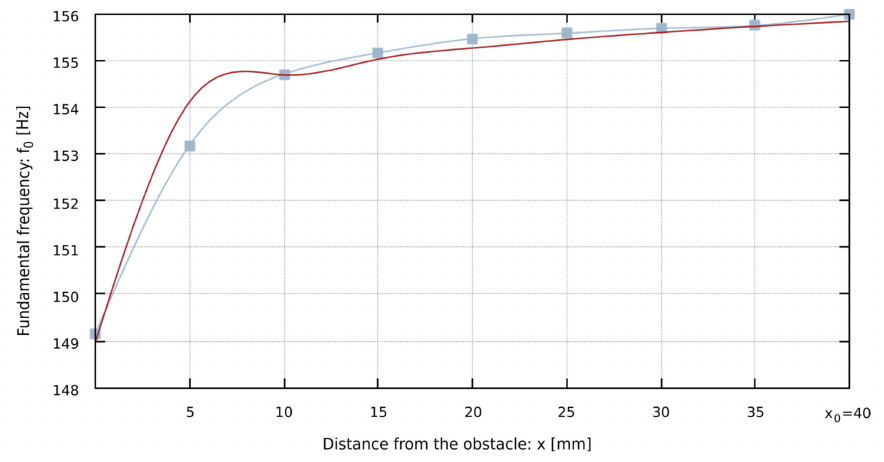
Figure 7. The comparison of the plots representing the dependence of the fundamental frequency f 0 on the distance of the obstacle x from the pipe’s mouth for Flute 4ft open D sharp. The grey squares represent the measured data (using DTFT). The grey solid line plot shows the interpolated fundamental frequency for the measured data. The red dotted plot shows data calculated from Equation